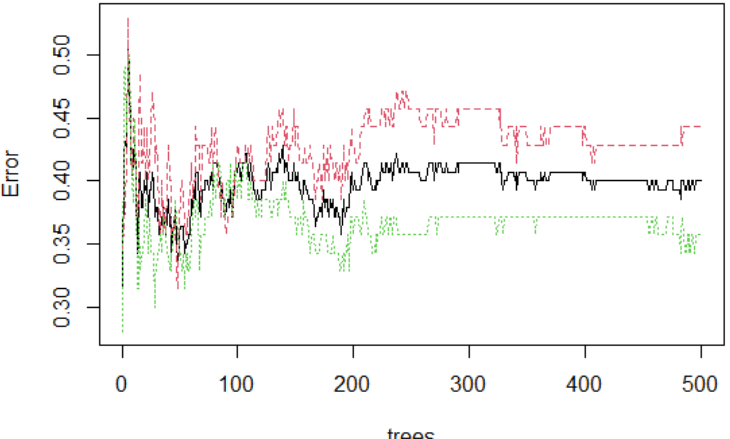
Figure 6. Random Forest (RF)